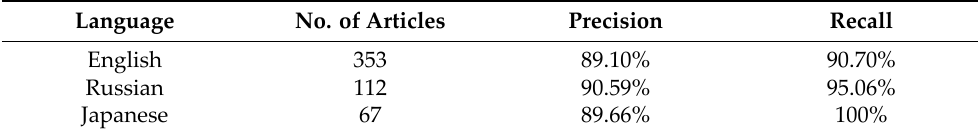
Table 2. Newsblaster performance for different languages.